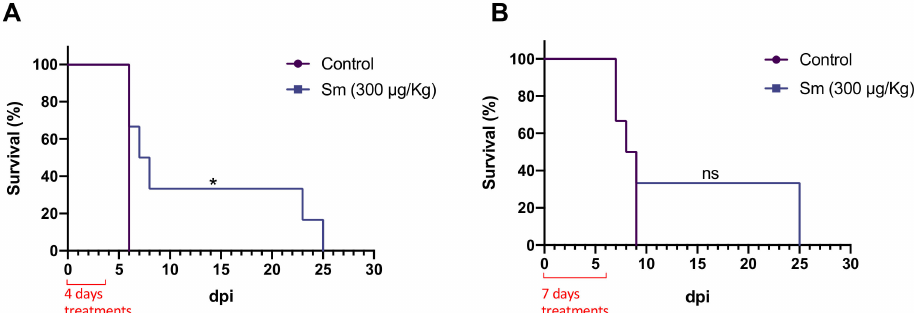
Figure 5. Effects of ( A ) 4 or ( B ) 7 days of treatment with 300 µ g/kg sparsomycin (Sm) on the survival of C57BL/6 mice infected with P. berghei ANKA. Mice were infected via inoculation with 1 × 10 7 infected erythrocytes. Each group consisted of six mice. *, significant ( p < 0.05); ns, not significant ( p > 0.05). Survival rates were calculated using the log rank (Mantel–Cox)